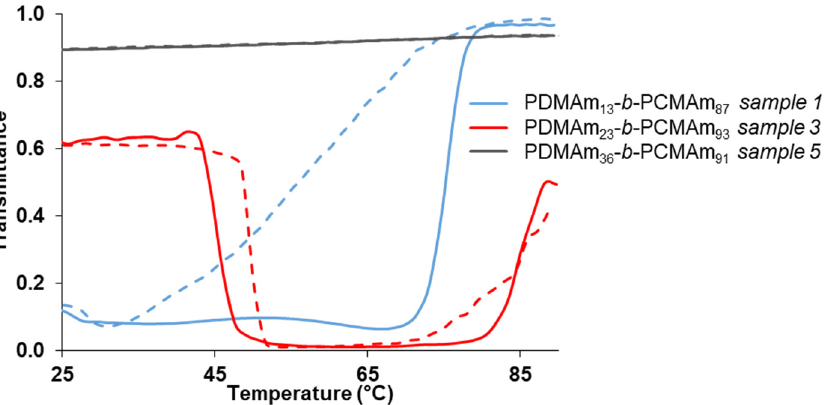
Figure 6. Turbidity curves of PDMAm x - b -PCMAm ~90 dispersions (Table 1) prepared at 1 wt% in water ( λ = 670 nm, 1 °C min − 1 ). First cooling: solid lines; second heating: dashed lines.